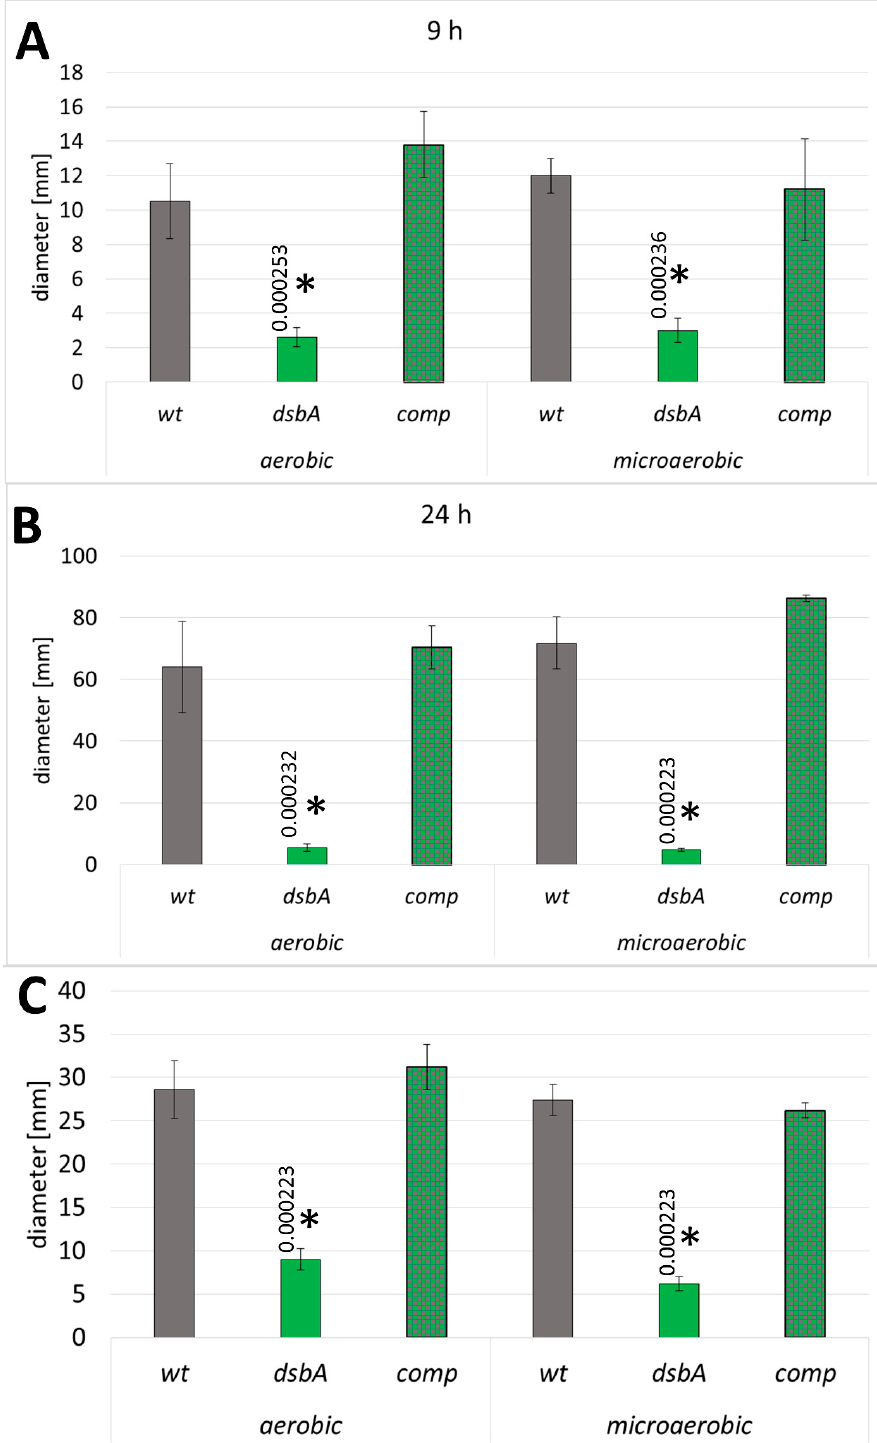
Figure 2. Effect of the dsbA knockout on the motility of D. solani . Mean values of swarming zones after 9 and 24 h of incubation ( A , B ) and swimming zones ( C ) are shown; wt—wild-type strain; dsbA —mutant strain TP02; comp—complemented strain TP03. The data represent values for five biological replicates. The statistical analysis of differences was determined by two-way analysis of variance (ANOVA) test followed by a post hoc Tukey test. The asterisks indicate statistical significance ( p < 0.001); the numbers next to asterisks show the actual p